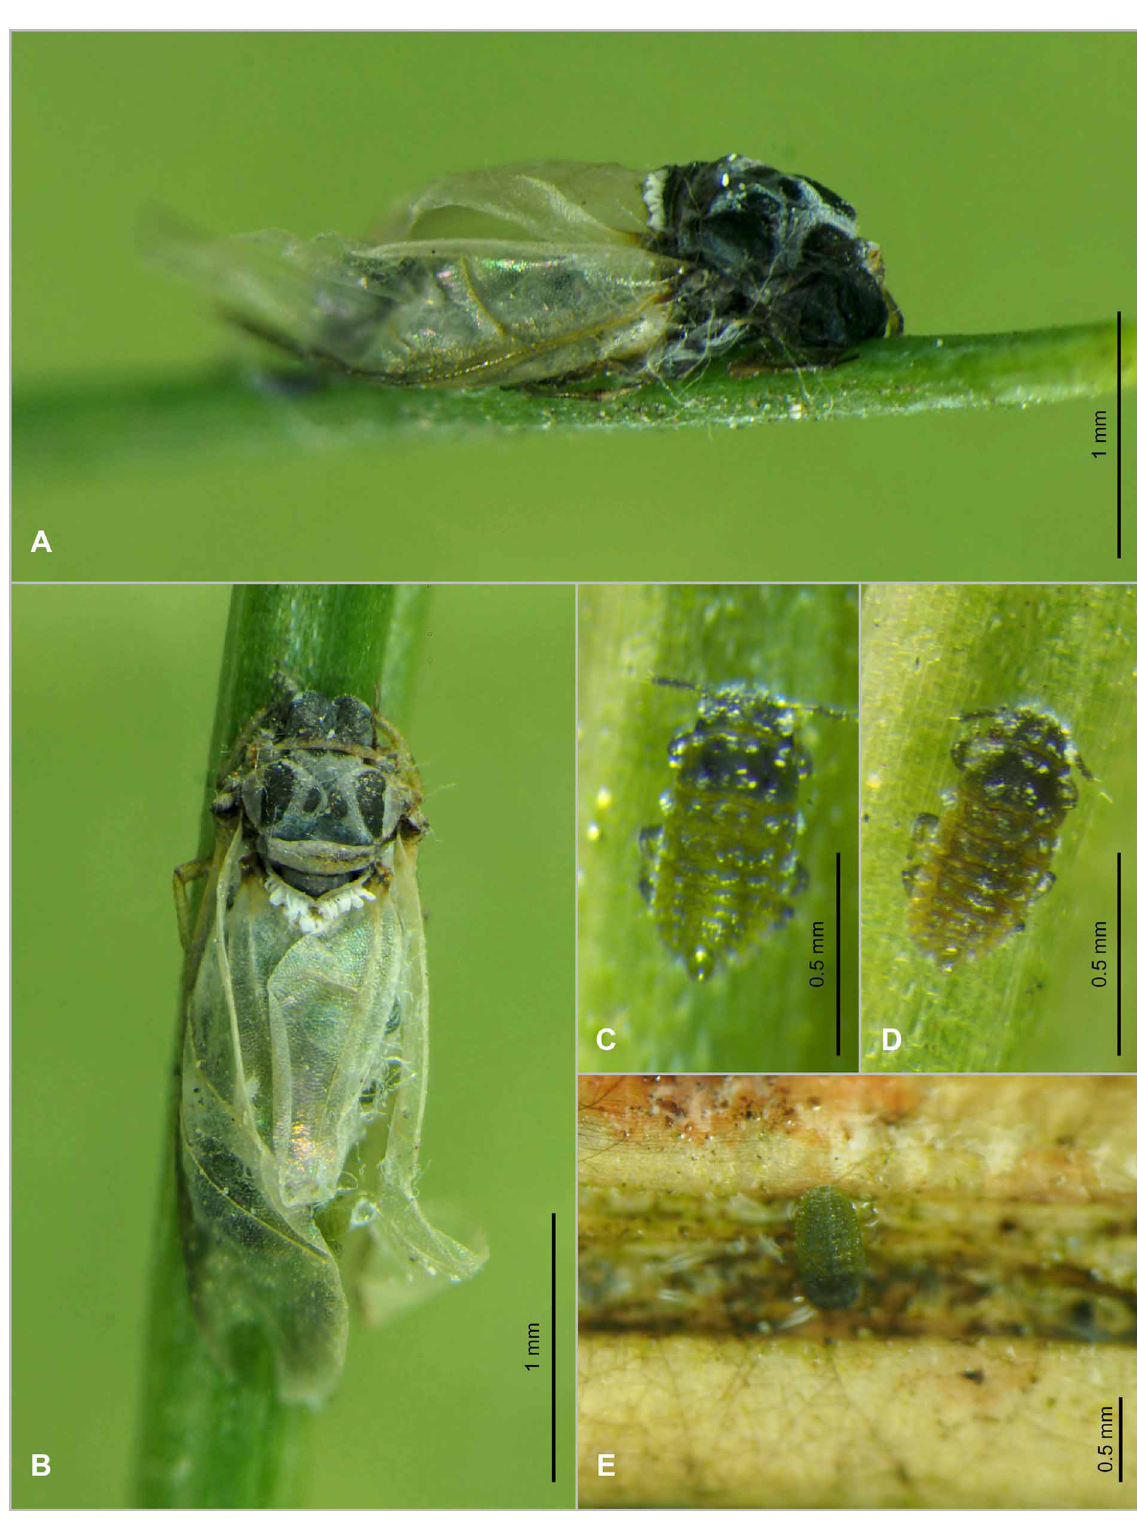
Fig. 56. Adelges (Sacciphantes) viridis (Ratzeburg, 1843) on Larix sibirica . A–B . Dead gallicolae on upper side of needle, with eggs and newly hatched neosistens under the wings. C–D . Neosistens on needle. E . Neosistens on bark of